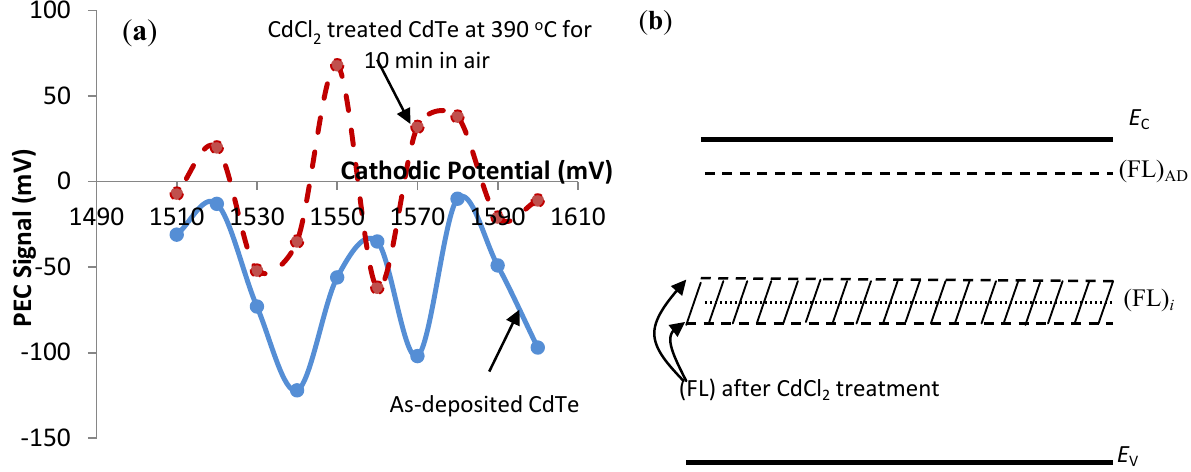
Figure 4. ( a ) Typical variation of the PEC signal when CdTe undergoes CdCl and ( b ) the corresponding FL positions before and after CdCl